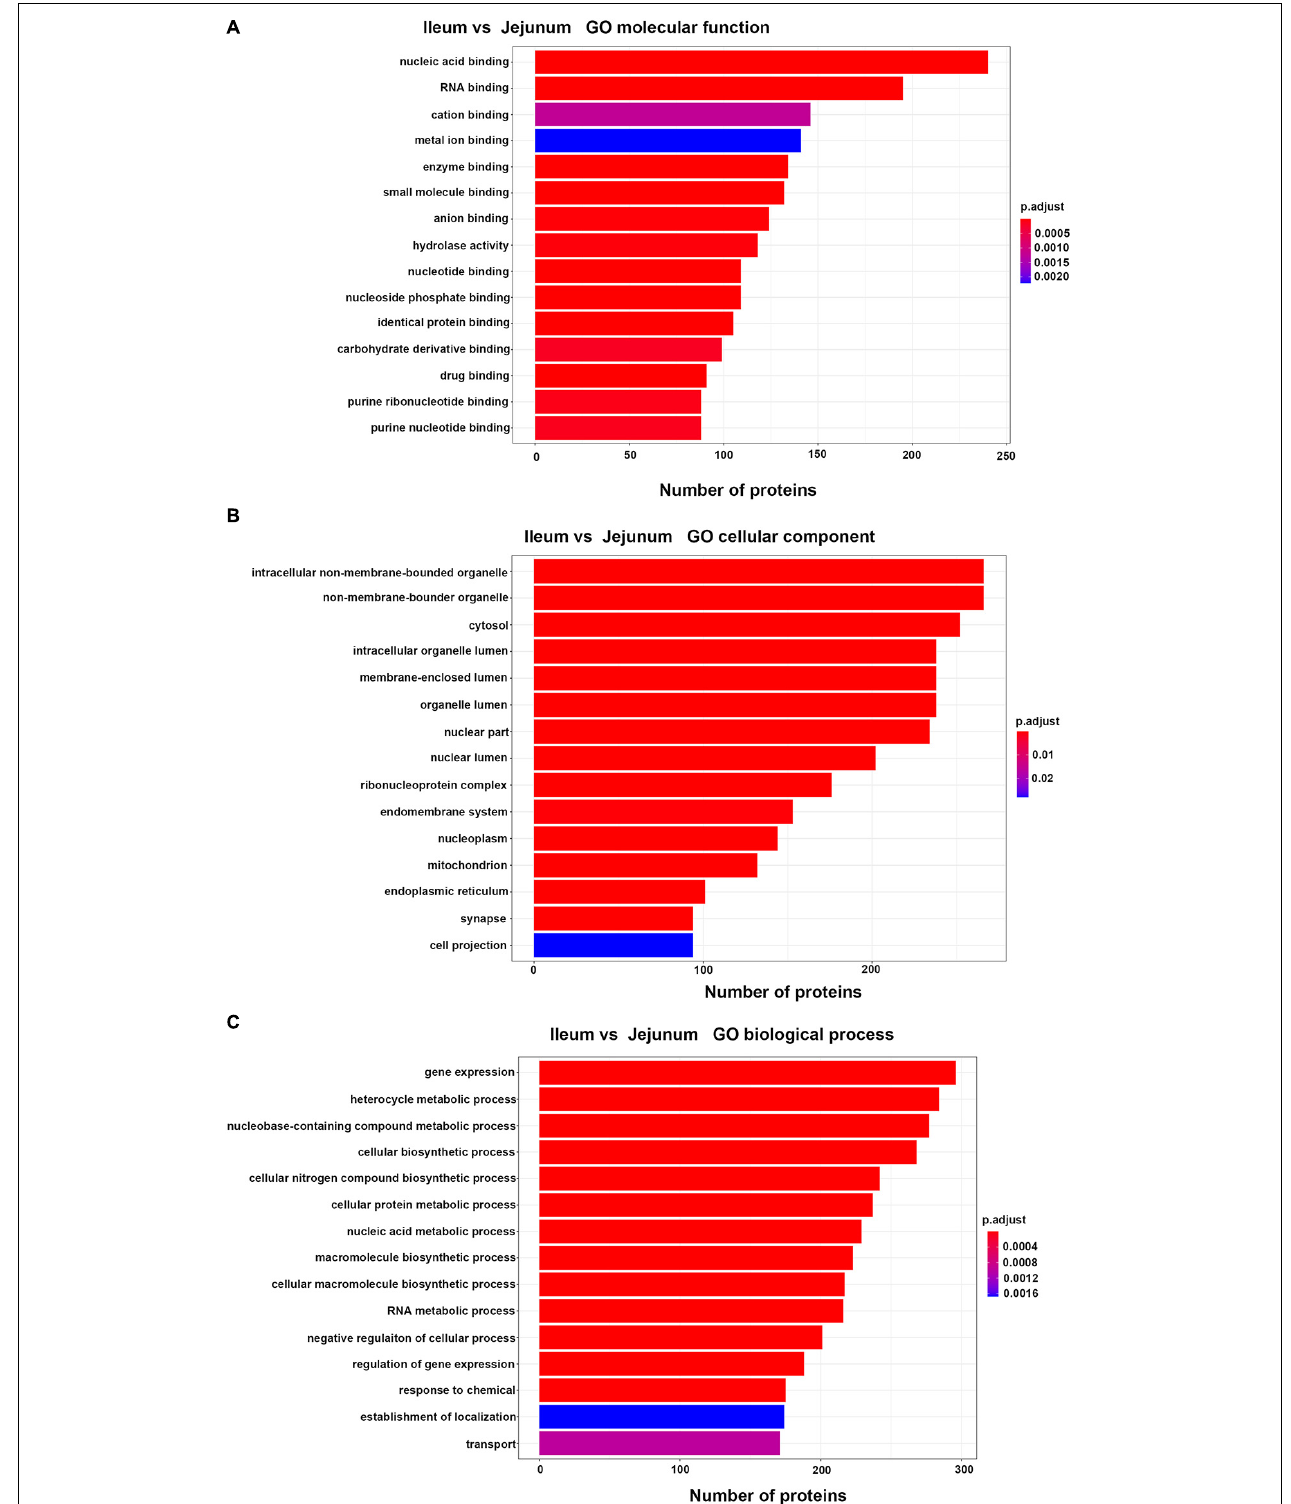
FIGURE 3 | Top 15 of GO enrichment analysis in differentially expressed proteins between ileum and jejunum IEC-Exos. (A) GO molecular function analysis. (B) GO biological process analysis. (C) GO cellular component analysis.